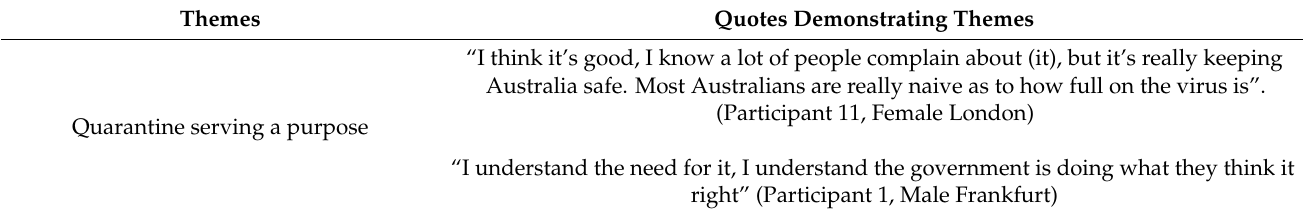
Table 6. The themes from interviews of